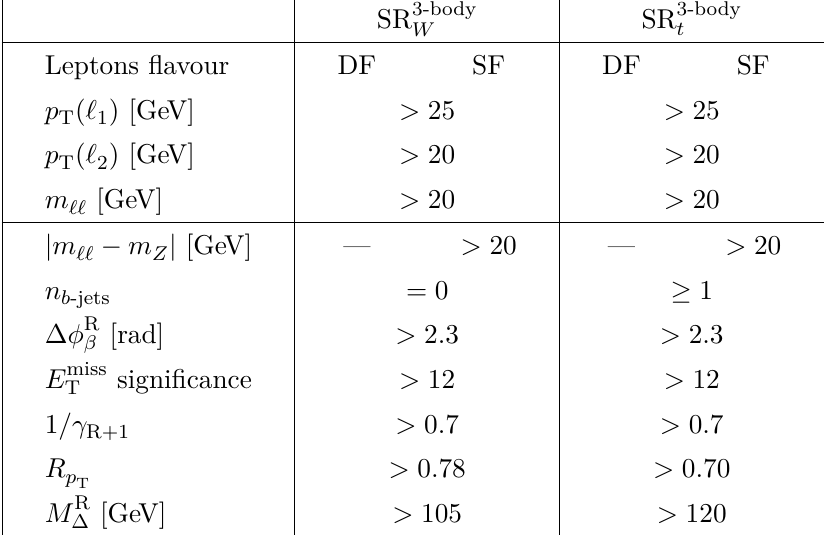
Table 3 . Three-body selection. Signal regions